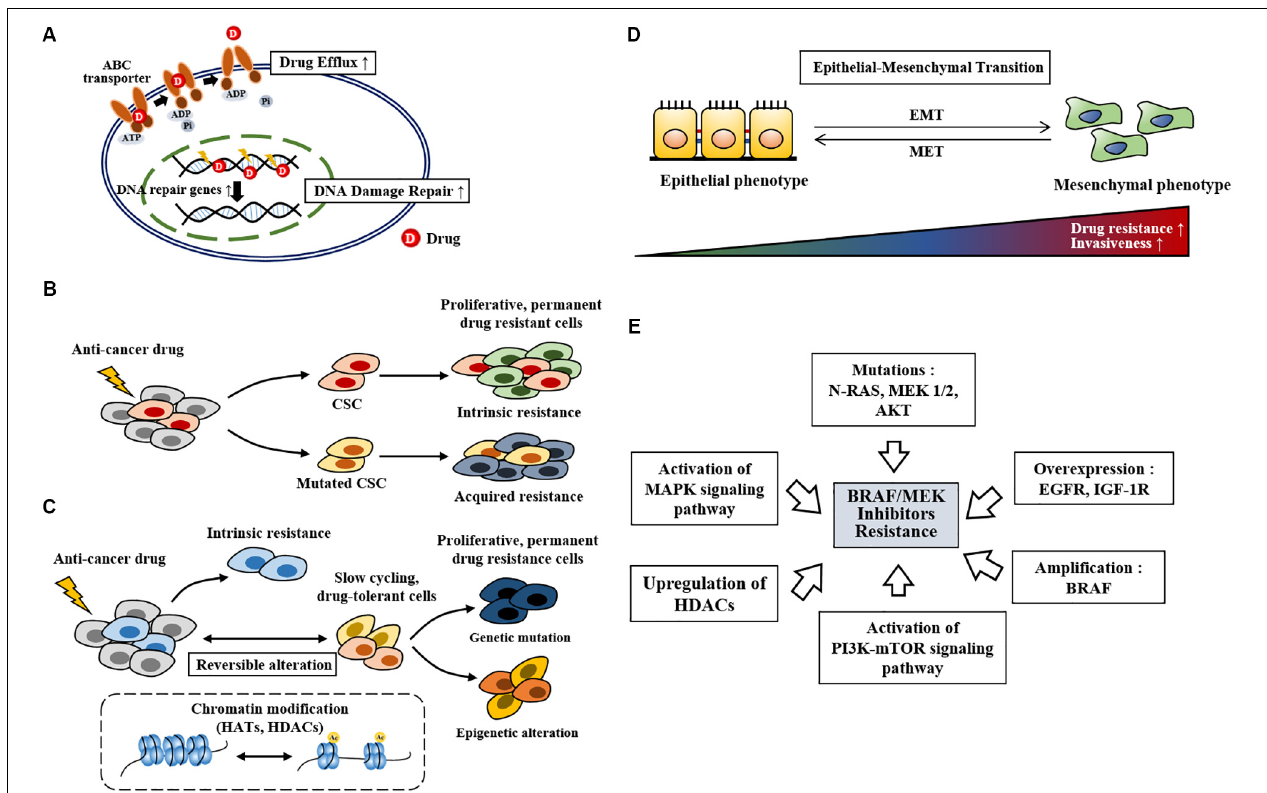
FIGURE 1 | The mechanisms of anti-cancer drug resistance. (A) Drug efflux by ABC transporter activity, drug inactivation, and alterations in drug targets leads to anti-cancer drug resistance. Increased DNA damage repair also leads to anti-cancer drug resistance. (B) Cancer stem cells survive anti-cancer drug treatment. Mutations (point mutations, gene amplifications etc.) in these cancer stem cells lead to anti-cancer drug resistant phenotypes. Cancer stem cells that survive anti-cancer drug treatment proliferates and lead to anti0cancer drug resistance (intrinsic resistance). CSC denotes cancer stem cell. (C) Slow-cycling drug-tolerant cells are selected on treatment by reversible epigenetic reprogramming. Further epigenetic reprogramming give rise to re-proliferating drug-resistant cells. Genetic mutation in slow-cycling drug-tolerant cells also give rise to permanent drug-resistant cells. HATs denote histone acetyl transferases. (D) Mesenchymal transition is closely related to increased drug resistance and invasiveness. MET denotes mesenchymal-epithelial transition. (E) Repeated exposure to BRAF inhibitors spurs resistance. BRAF inhibitor resistance develops from gene amplification, gene overexpression, genetic mutations, activation of signaling pathways, and upregulation of